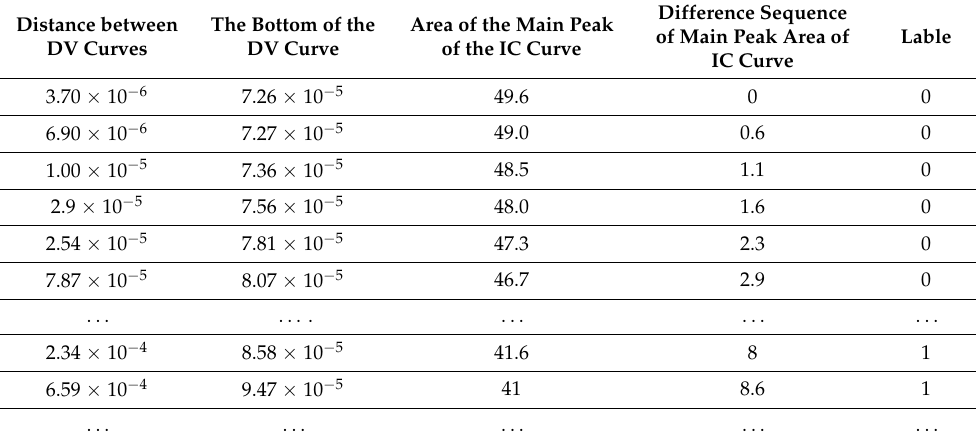
Table 2. Training set. Distance between DV Curves